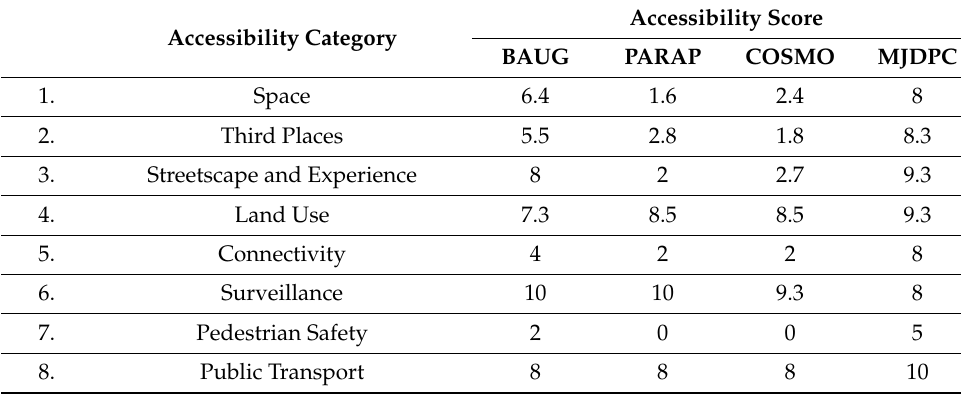
Table 3. Accessibility Framework: accessibility score based on participants’ perceptions of neighbor-